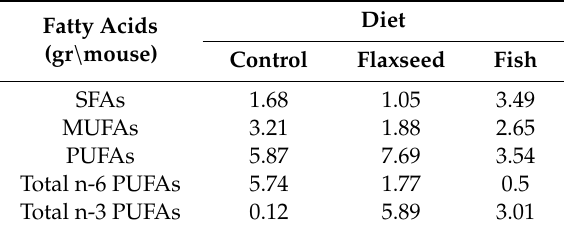
Table 2. Di ff erences in FA content between the diets.